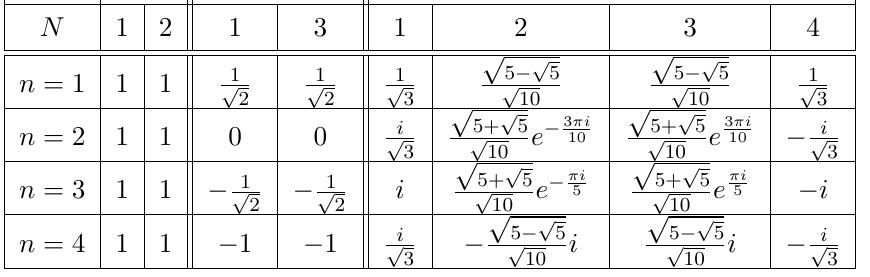
h i U ( N ) for 3 ≤ k ≤ 5 , 1 ≤ N ≤ k − 1 and 1 ≤ n ≤ 4 with b = 1 . k, − 2 h i U ( N ) as in (3.6). This table shows k, − 2